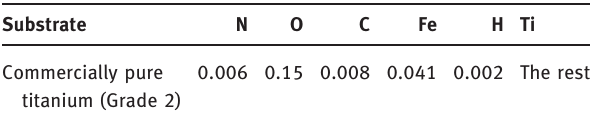
Table 1: Chemical composition of pure titanium (wt.%).